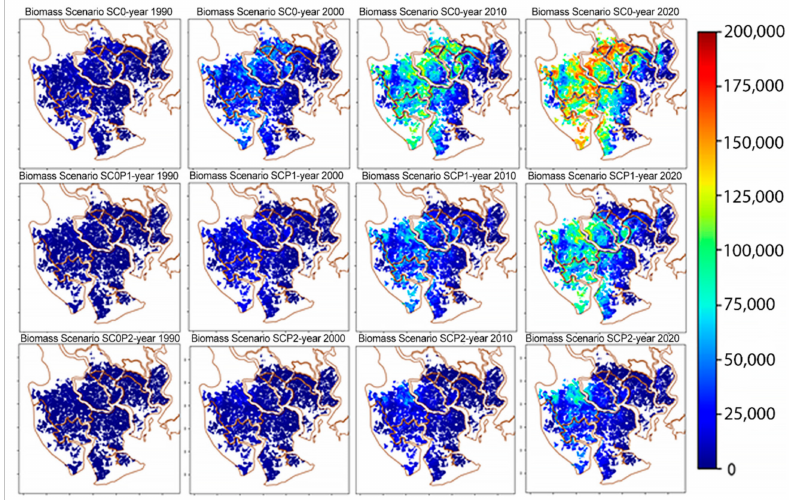
Figure 8. Distribution patterns of trunk biomass over time in di ff erent scenarios. The columns show the biomasses at di ff erent times, the rows show the results for the three